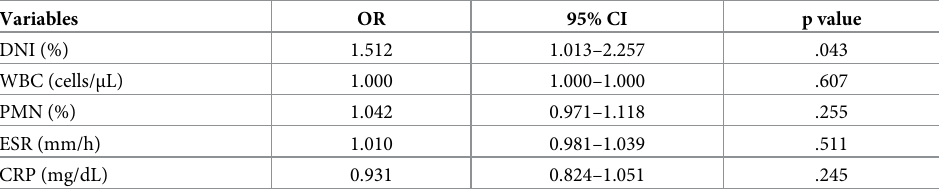
Table 3. Predictors of surgical intervention for foot and ankle infection as determined by univariate logistic regression